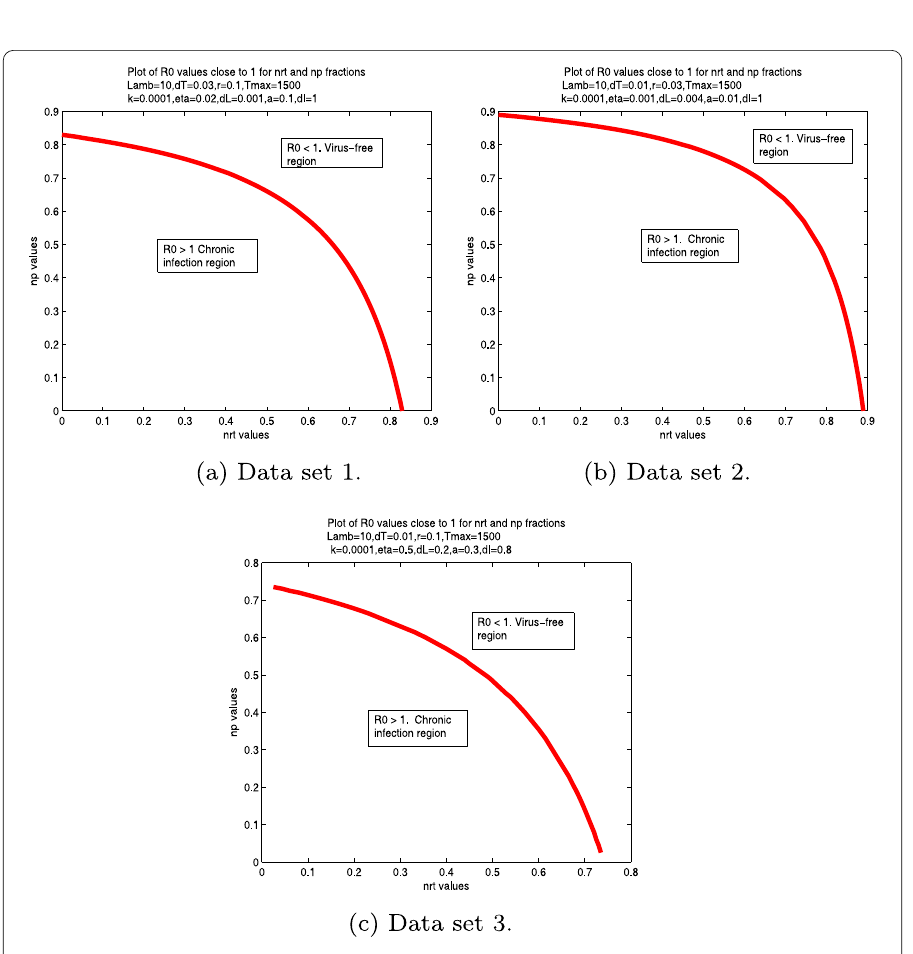
Figure 1 Plots of the curve R 0 = 1 separating the virus-free and chronic equilibrium regions as a function of n rt and n p for the data sets 1, 2 and 3 in Table